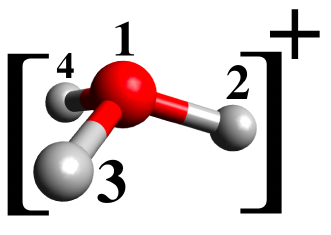
Figure 5. A hydronium cation which is assumed to form after proton transfer from the photoacids considered in this work. The transferred proton is denoted as 3. Table 2. Bond lengths and angles of a hydronium molecule with additional optimized effective potential on one proton (number 3 in Figure5). The optimized parameters are the same as in Table1.